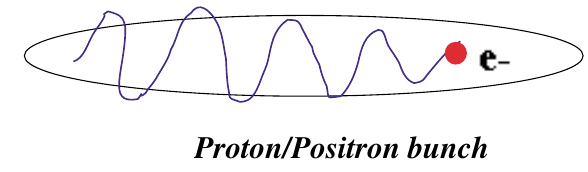
FIG. 10. (Color) The electron motion during a bunch passage.